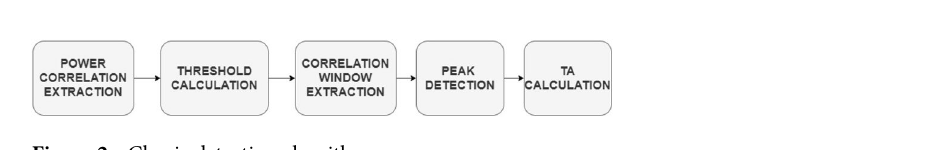
Figure 2. Classic detection